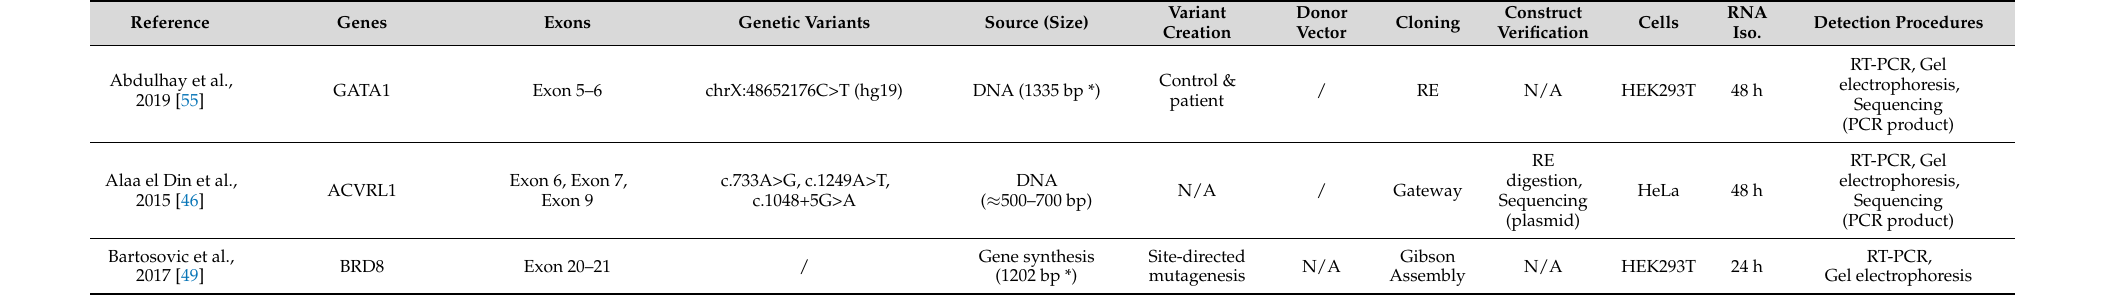
Table 2. Experimental setup for the minigene assays applied in the 25